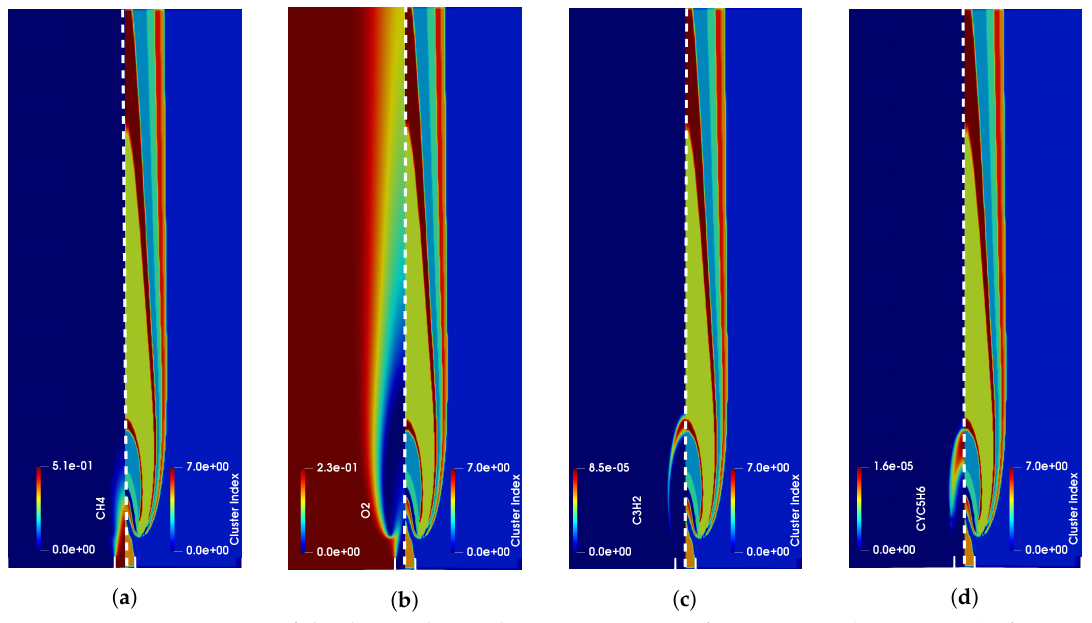
Figure 2. Comparison of the thermochemical space partitioning for a timestep ( t = 0.0025 s) of an unsteady 2D laminar coflow flame adaptive simulation (right part of each contour) with the maps (left part of each contour) of: ( a ). CH 4 mass fraction; ( b ). O 2 mass fraction; ( c ). C 3 H 2 mass fraction; ( d